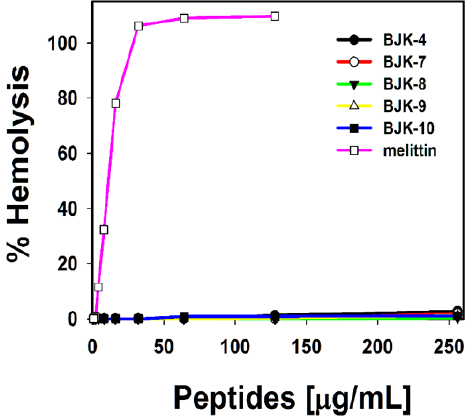
Figure 3. Hemolytic activity of BJK-4 , BJK-(7-10) and melittin against sheep red blood cells (sRBCs). Cytotoxicity